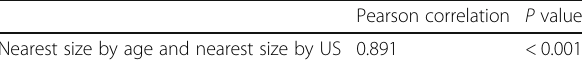
Pearson correlation P